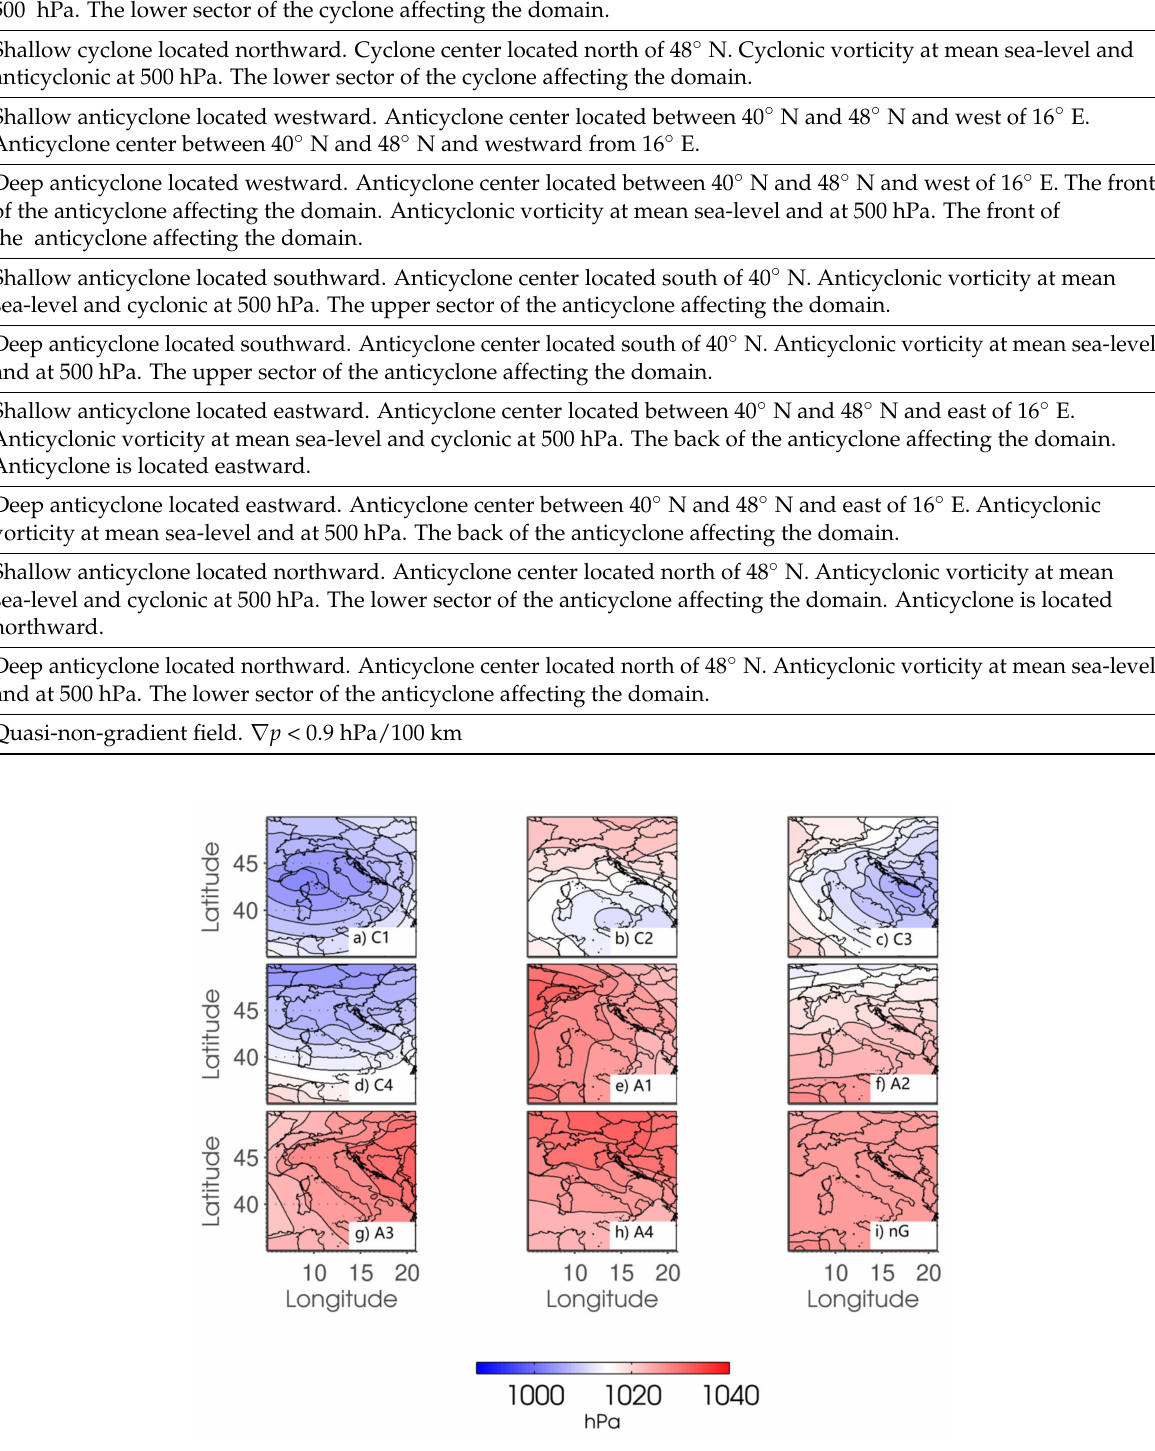
Figure 2. The 30-year mean of MSLP (including both deep and shallow cases) in the near-present period (1971–2000) for the DJF season. The presented example is for the RCA model forced by one of the GCMs (CNRM-CERFACS-CNRM-CM5). ( a ) Front sector of cyclone (C1), ( b ) upper sector of cyclone (C2), ( c ) back sector of cyclone (C3), ( d ) lower sector of cyclone (C4), ( e ) front sector of anticyclone (A1), ( f ) upper sector of anticyclone (A2), ( g ) back sector of anticyclone (A3), ( h ) lower sector of anticyclone (A4), ( i ) quasi-non-gradient field